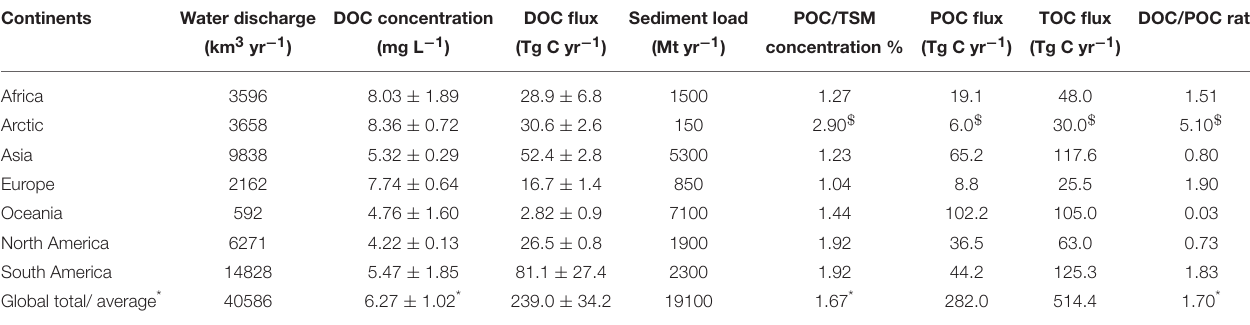
TABLE 2 | Data-based, continent-wise estimates of terrestrial DOC, POC, and TOC.